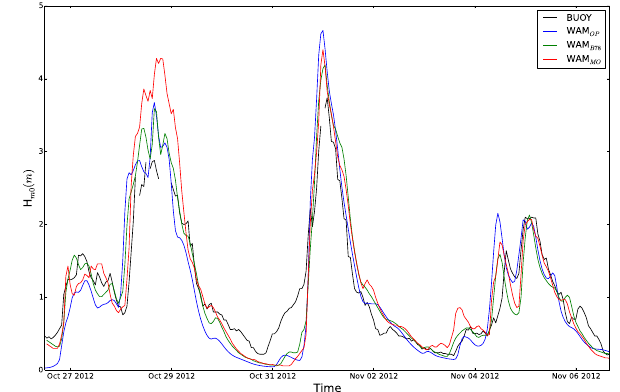
Figure 13. Test-case 1: Comparison between wind forecast and anemometer data at Venice during the first test case.